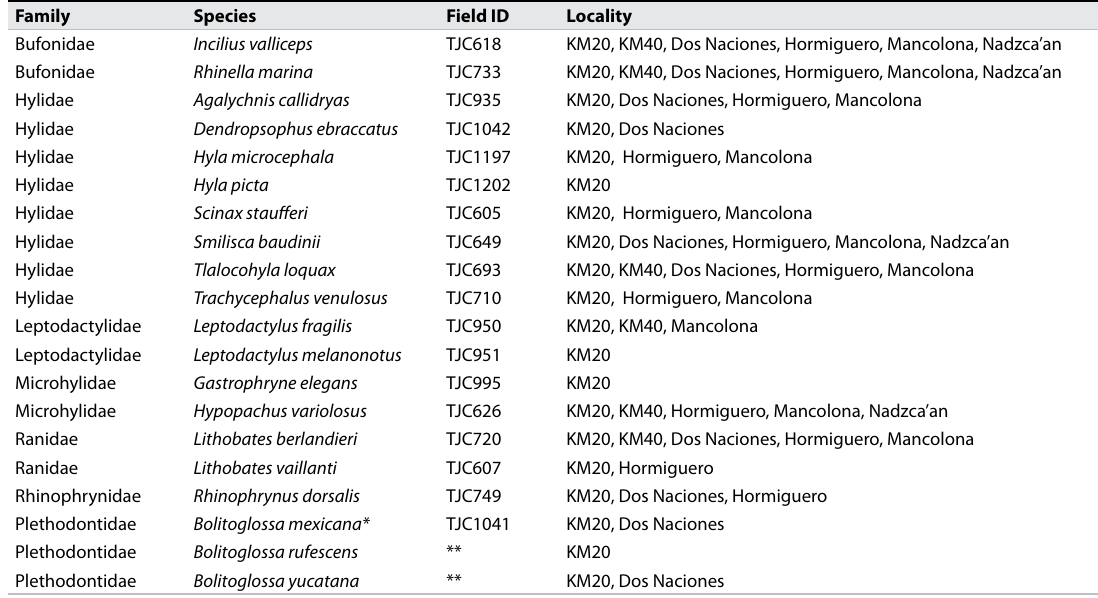
Table 1. List of amphibians encountered in the CBR. *New records not previously reported for the area. ** Digital voucher only. Family